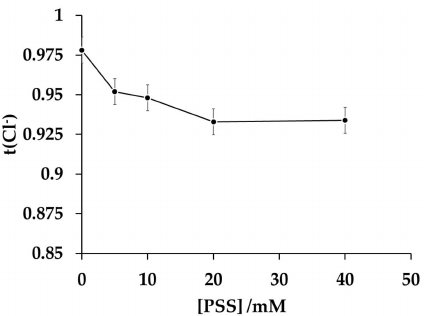
Figure 12. Transport number of Cl − (t(Cl − )) as a function of the polyelectrolyte concentration in solution used to modify the commercial AFN